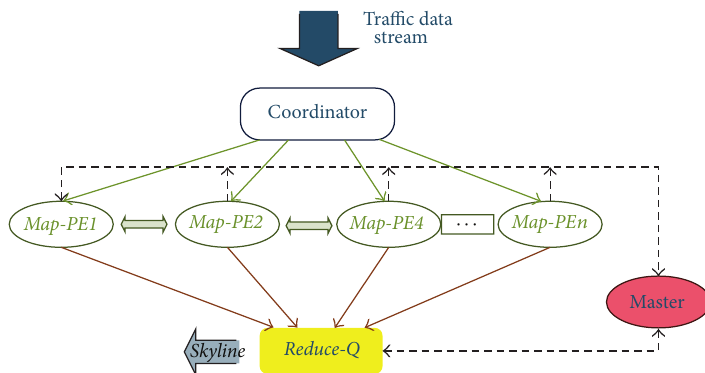
Figure 7: Processing framework of transportation stream